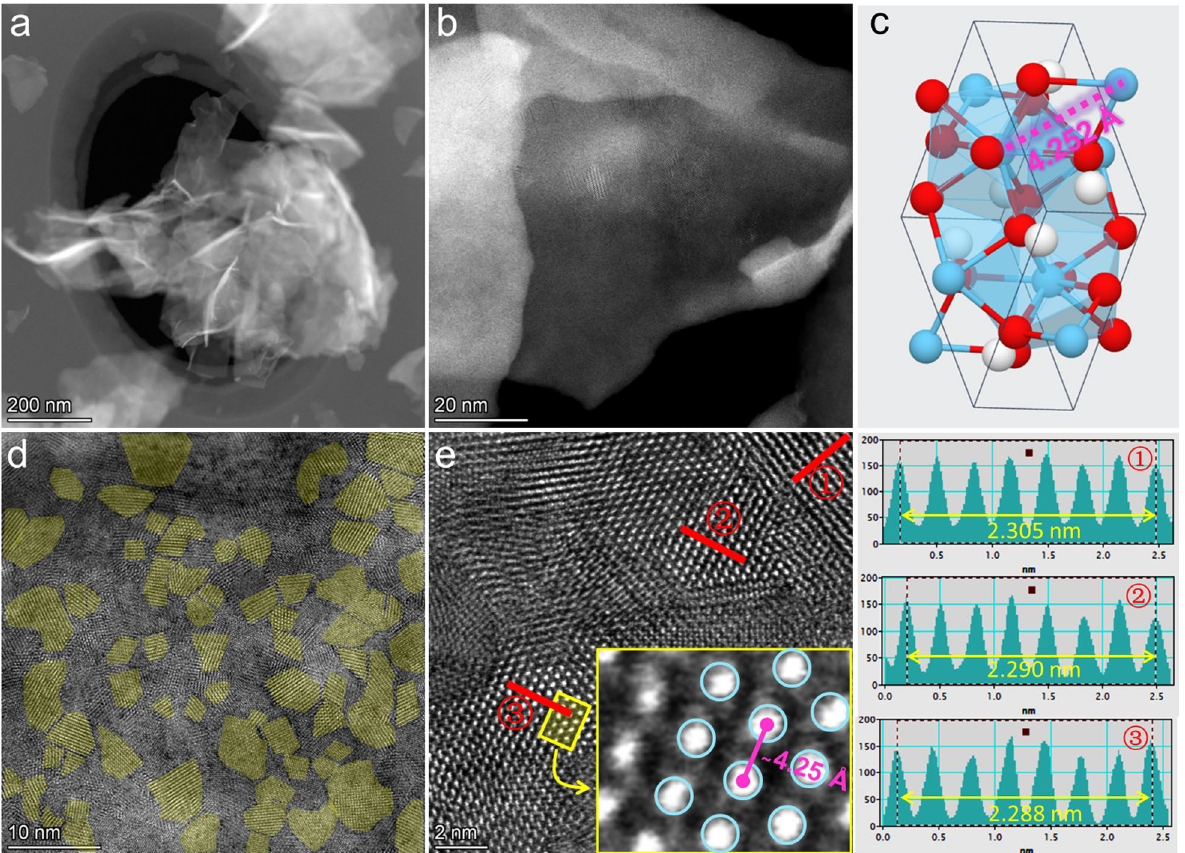
Fig. 3 AC-HRTEM with HAADF mode ( a , b , d , e ) of MSBL3; ( c ) crystal lattice model and lattice spacing of La(OH) 3 on